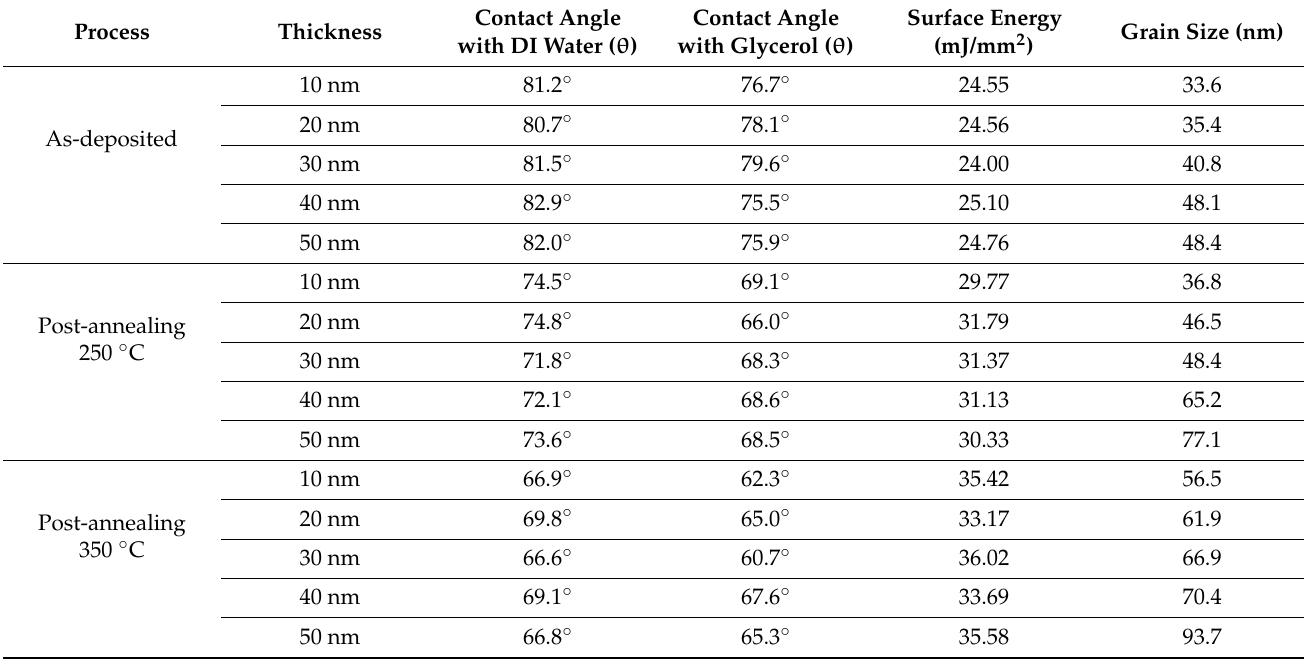
Table 1. Comparing contact angle, surface energy, and grain size for Co 40 Fe 40 W 20 thin films from different fabrication